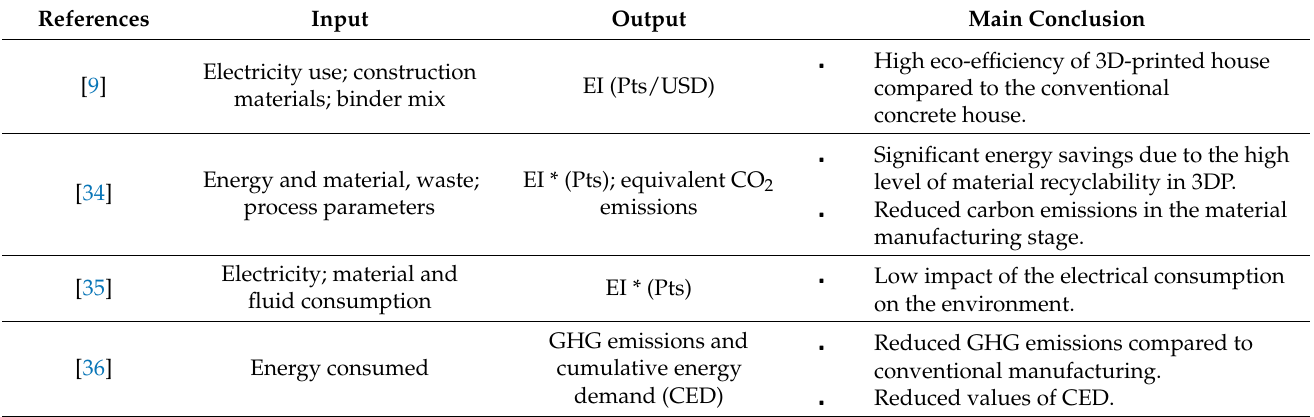
Table 2. Summary of the environmental assessment of the 3DP